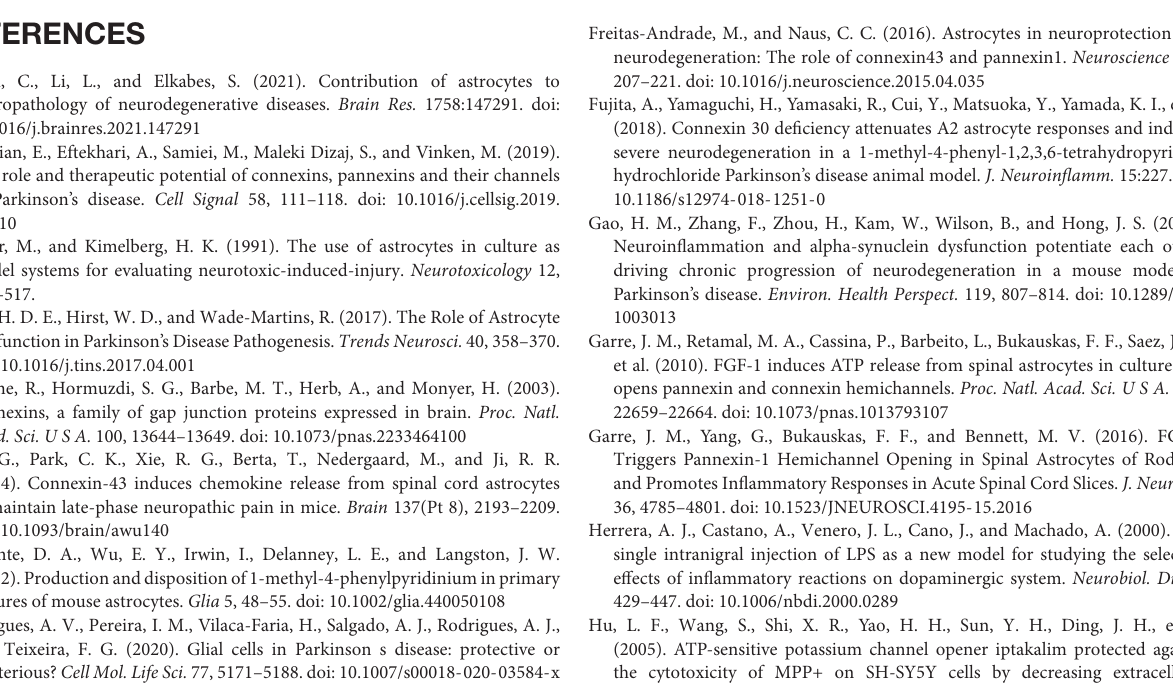
Quantification of TH + neurons in PBS and MPTP groups. Statistical comparison were performed using Student’s t -test; ∗∗ p < 0.01. Scale bar, 20 µ m. Supplementary Figure 2 | (A,B) The effect of MPP + at different concentrations for 24 h on the viability of SH-SY5Y cells and primary cultured astrocytes. The